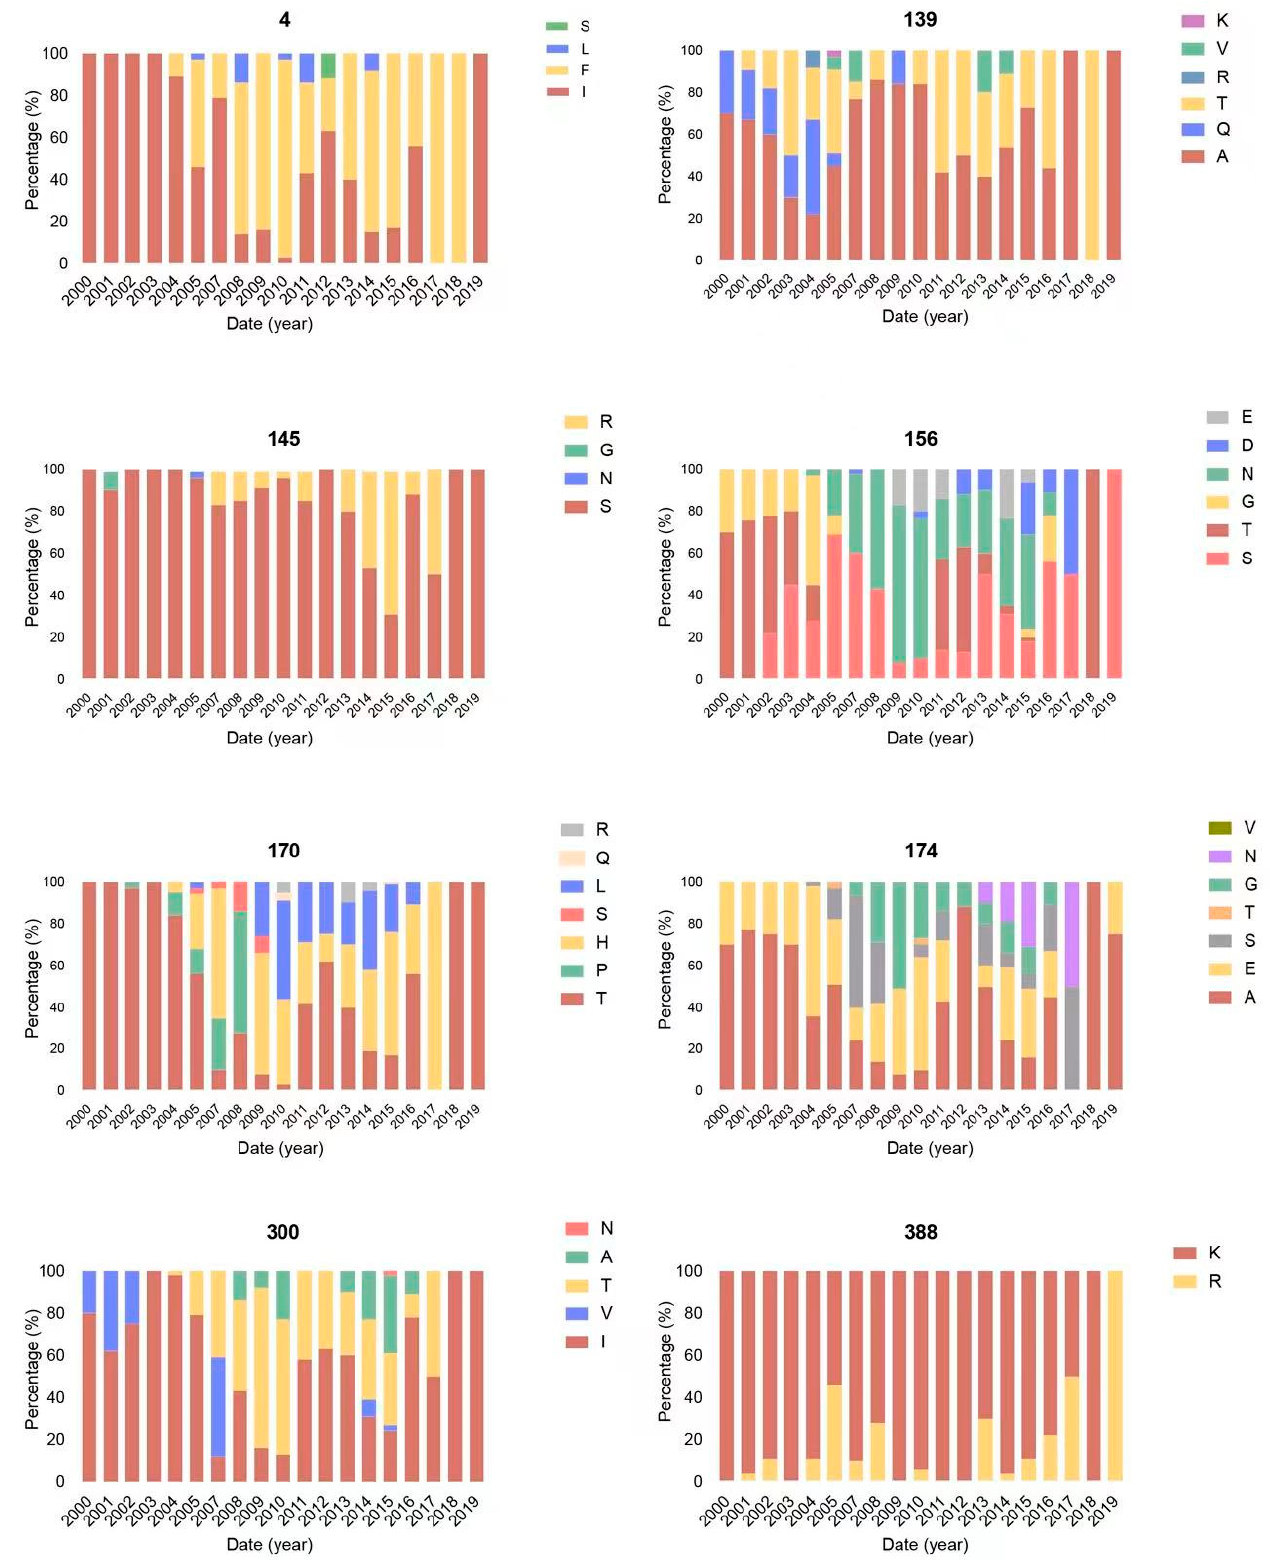
Figure 7. The positively selected sites of the HA protein of H6Nx viruses.